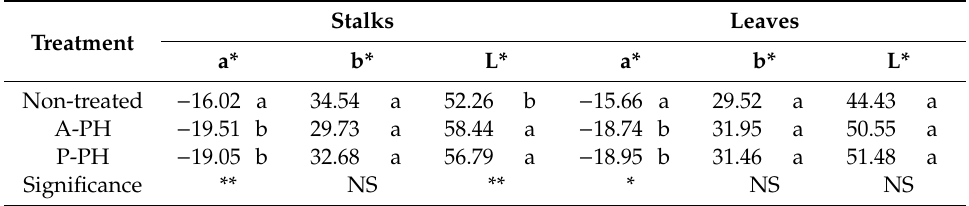
Table 4. E ff ect of di ff erent PHs on stalks and leaves color coordinates of celery.